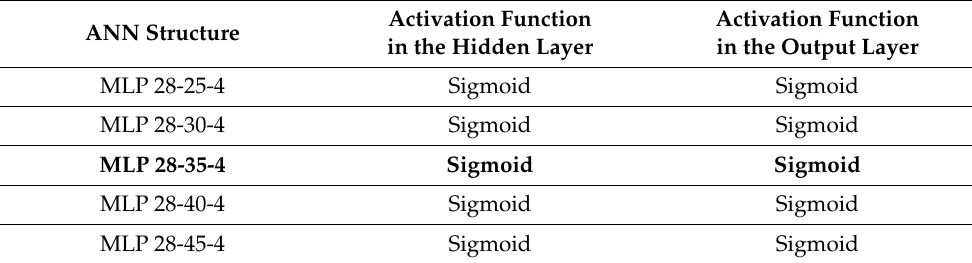
Table 3. The best MLP network models for diagnostic measures. ANN Structure